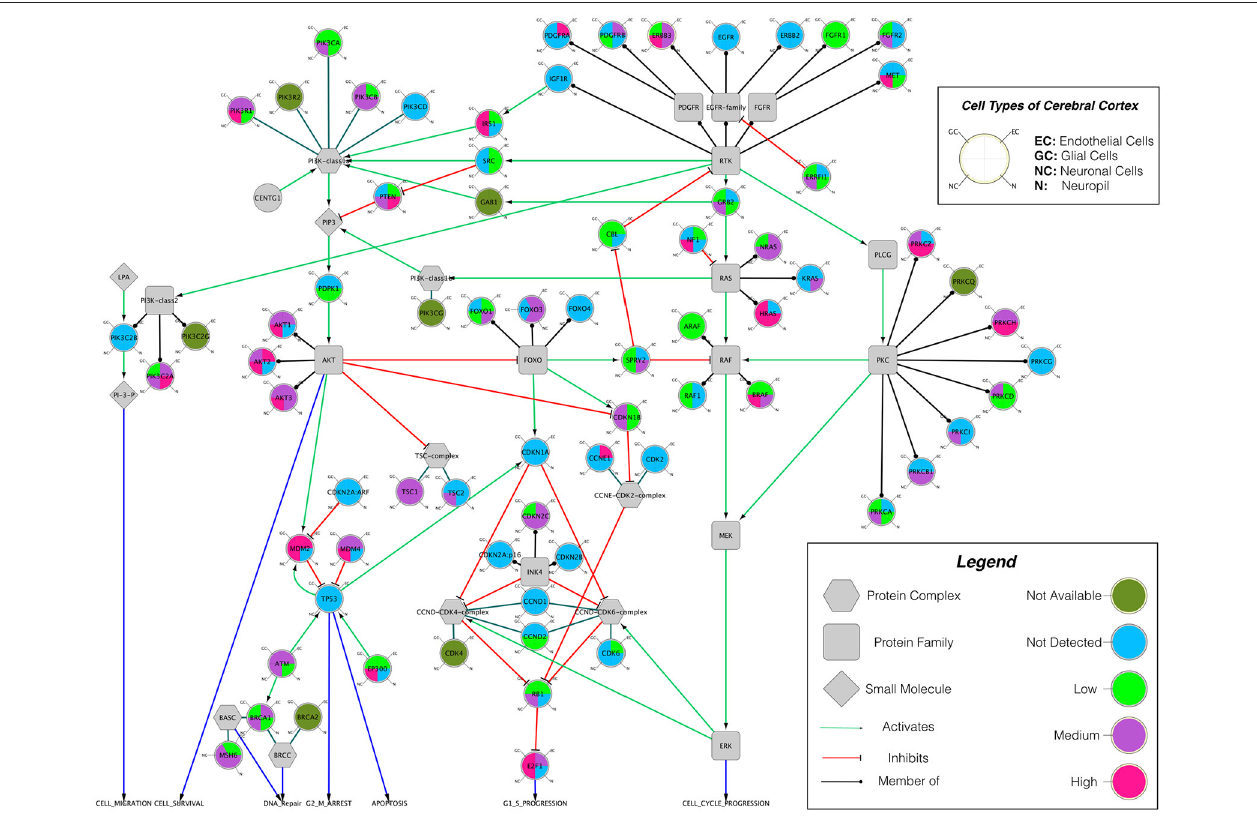
FIGURE 3 | The protein expression levels of healthy cerebral cortex cells mapped onto the GBM pathway map from the TCGA data set. In this diagram, The Human Protein Atlas database was used to obtain protein expression levels of healthy cerebral cortex cells. Special shapes used in the map represent different types of molecules which are given in the legend of the figure as protein complex, protein family, protein or small molecule. Lines and arrows show the relationship of the molecules. Each protein symbol (circle) is divided into quarters to represent, in a clockwise order: endothelial cells, neuropil, neuronal cells, and glial cells. The corresponding protein expression levels are shown in different colors. Olive for not available, deep sky blue for not detected, green for low expression, medium orchid for medium expression, and deep pink for high expression. The original GBM pathway map in the Cytoscape format was downloaded from (“The Cancer Genomics at cBio—Glioblastoma (TCGA)” n.d.).